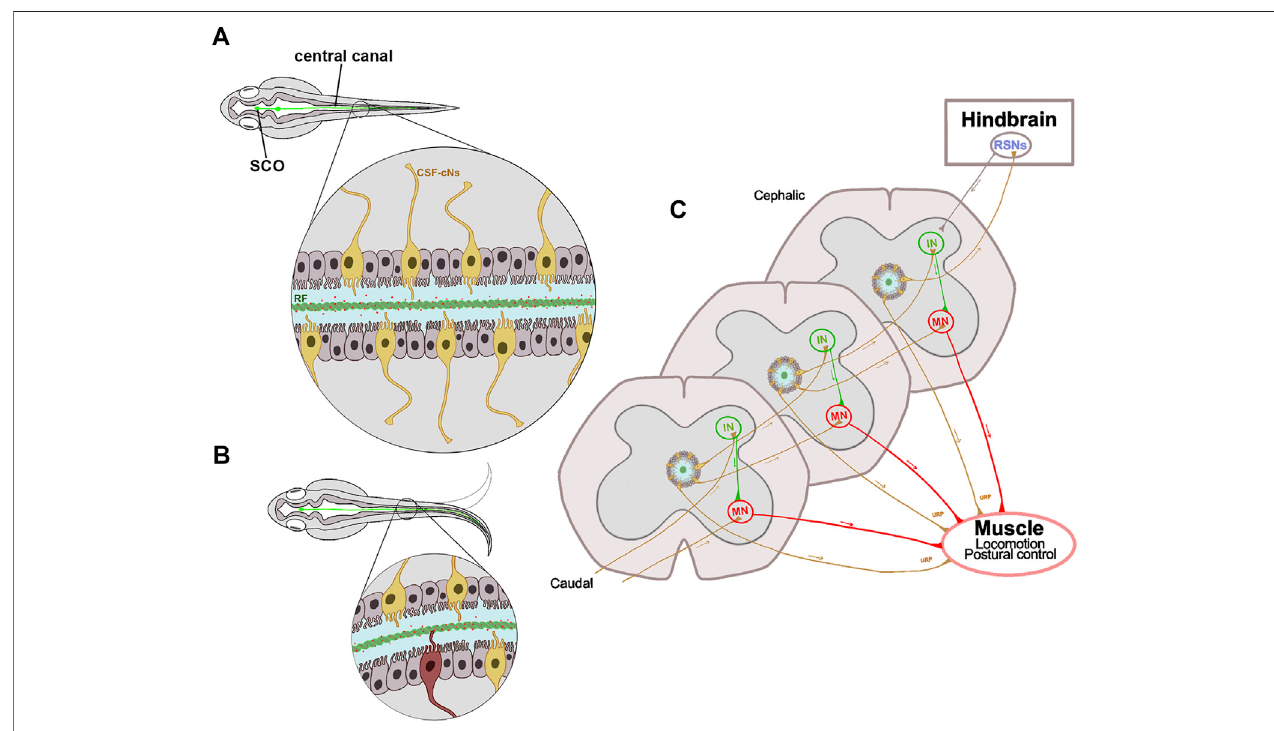
FIGURE 2 | Schematic representation of the proprioceptive organ conformed by RF and CSF-cNs. (A) The central canal in a zebra fi sh embryo is surrounded by ependymal ciliated cells (gray) necessary for the CSF fl ow, and by sensory CSF-cNs (yellow). The RF (green cord) runs from the SCO to the entire spinal cord inside the centralcanal.TheRFbindsandtransportsepinephrineandnorepinephrinemolecules(reddots)thattriggerUrp1andUrp2expressioninmechanosensoryCSF-cNs. (B) The curvature of the spinal cord during locomotion, allows the interaction between RF and CSF-cNs (highlighted in red); thus, transferring information through a spinal circuit and shaping the spinal curvature. (C) CSF-cNs project an ipsilateral ascending axon that synapses onto premotor INs, onto primary MNs or directly onto muscle that expresses the Urp receptor. Additionally, the most cephalic CSF-cNs send their axons to RSNs in the hindbrain, that in turn send descending motor commands to the spinal cord. All these projections participate in the correct muscle contraction and postural control. SCO, subcommissural organ; CSF, cerebrospinal fl uid; CSF-cNs, CSF contacting neurons; RF, Reissner fi ber; Urp, urotensin neuropeptides; IN, interneuron; MN, motor neuron; RSN, reticulospinal neuron.